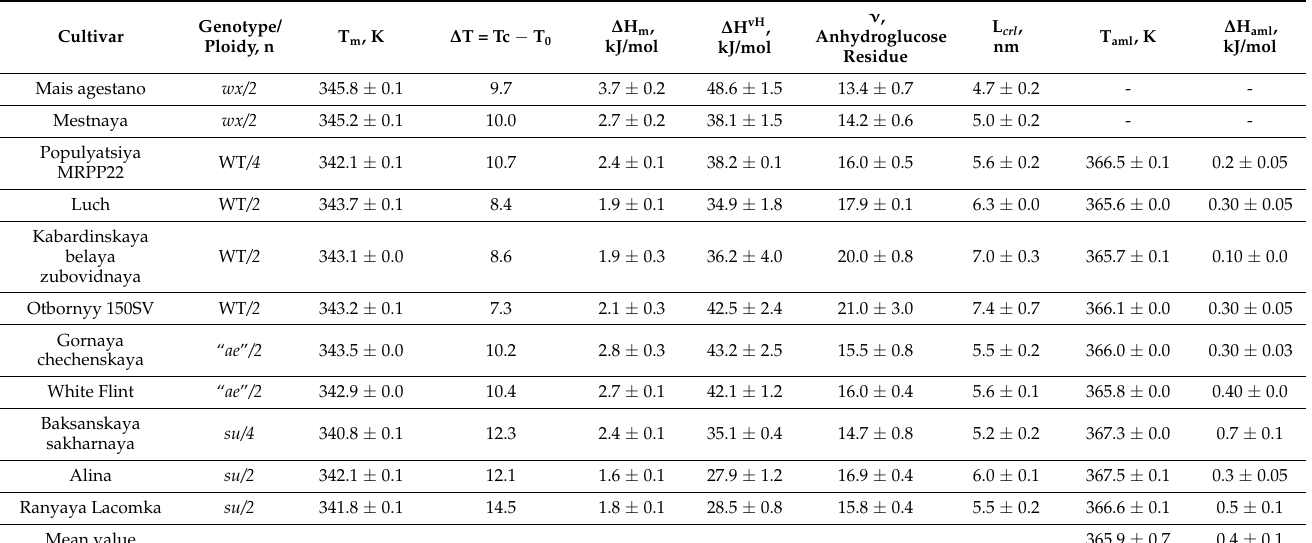
Table 3. Thermodynamic melting parameters of maize starches with different genotype (melting temperature (T m ), melting enthalpy ( ∆ H m ), van’t Hoff’s enthalpy( ∆ H vH ), cooperative melting units ( ν ), and thickness (L crl ) of crystalline lamellae; T aml and ∆ H a ml are the temperature and enthalpy of amylose–lipid complex